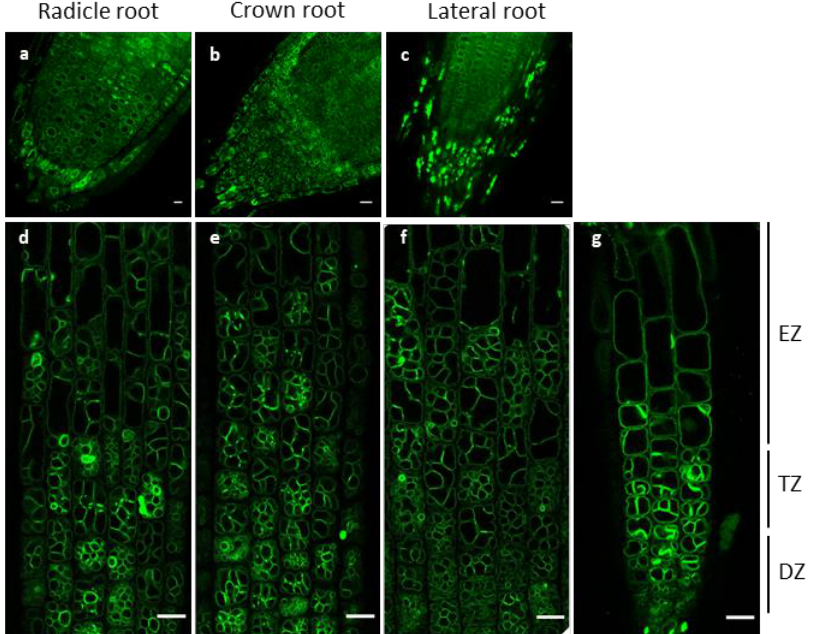
Figure 4. Different root types display similar vacuole organizations in their epidermal cell layers. ( a – c ) The root cap regions of the radical, crown, and lateral roots, respectively. ( d – f ) The subapical region of radical, crown, and lateral roots, respectively. ( g ) The subapical region of a lateral root which shows a different vacuole morphology compared to other root types. Approximate sub-apical regions are indicated as elongation zone (EZ), transition zone (TZ), and division zone (DZ). Scale bars: 10 µm.